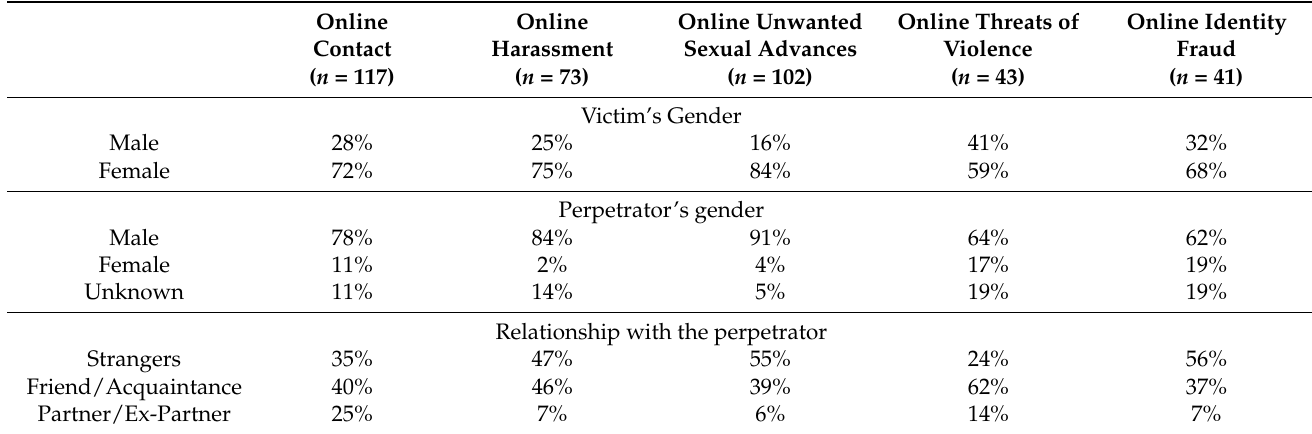
Table 1. Distribution of the cyberstalking